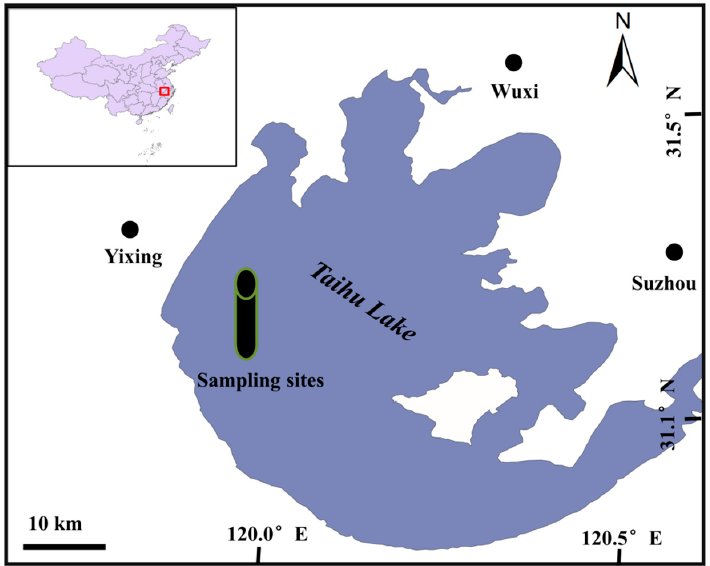
Figure 1. Location of the study area and sampling sites.